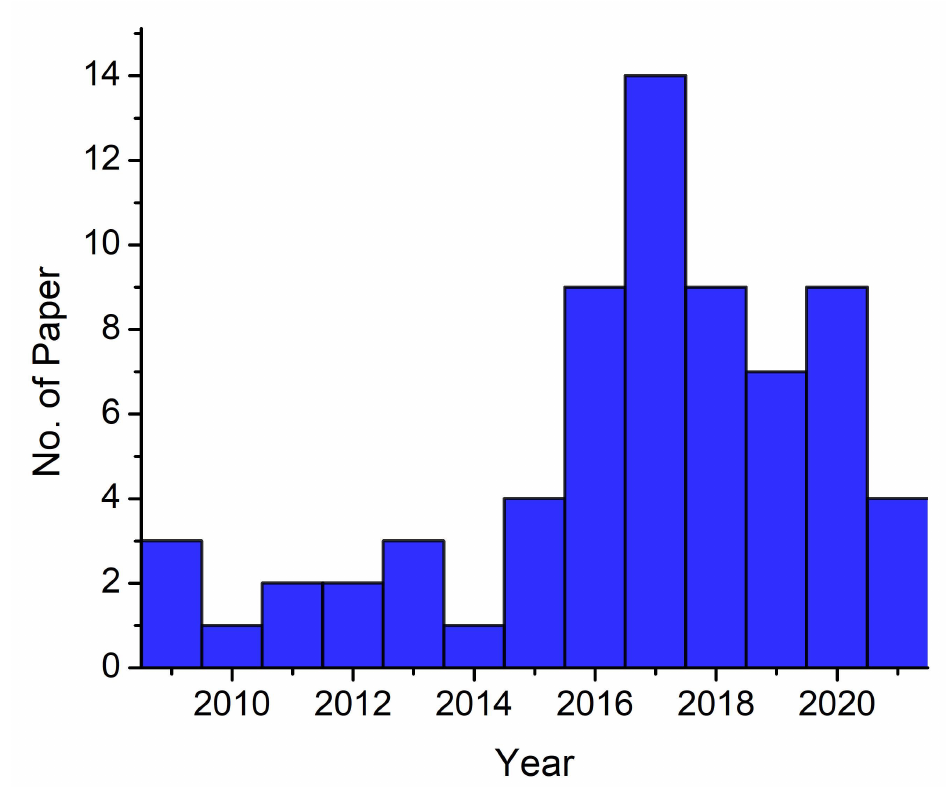
Figure 5. Histogram of number of papers published with respect to